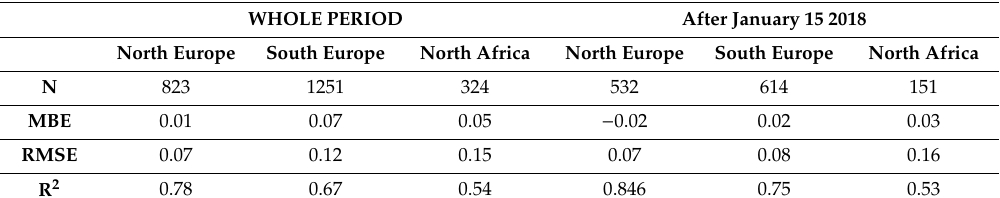
Table 5. MBE, RMSE and R 2 AOT values for di ff erent regions (North Europe, South Europe, and North Africa / Middle East) corresponding to the whole period and to the period after 15 January, 2018.